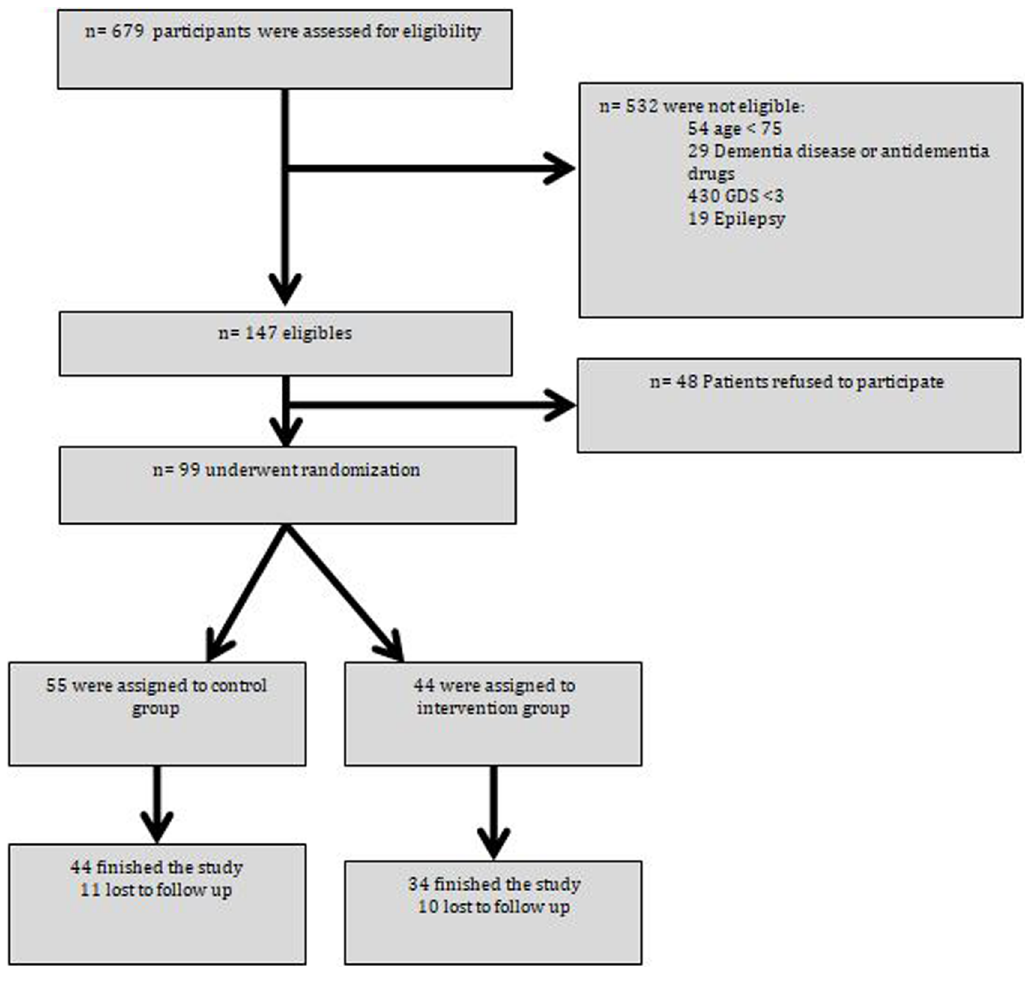
Fig 1. Flow chart of